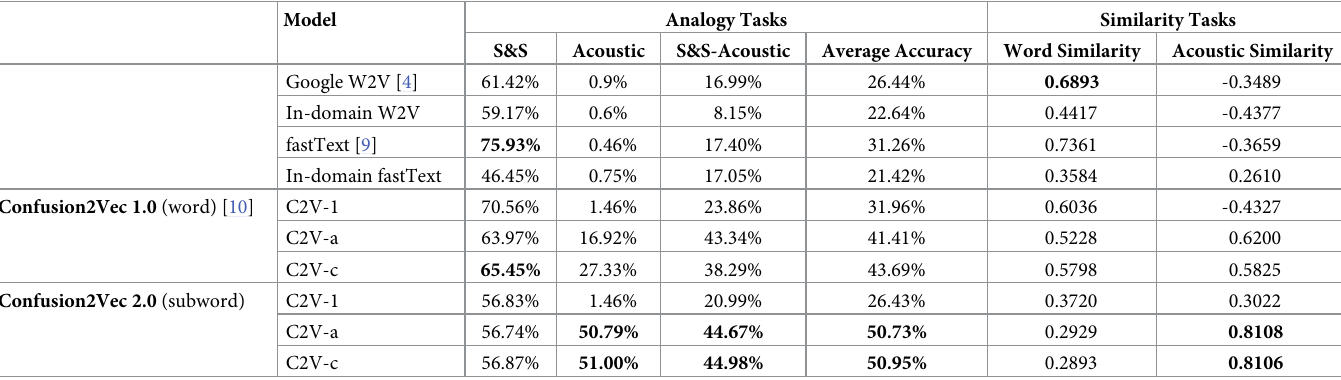
Table 1. Results: Different proposed